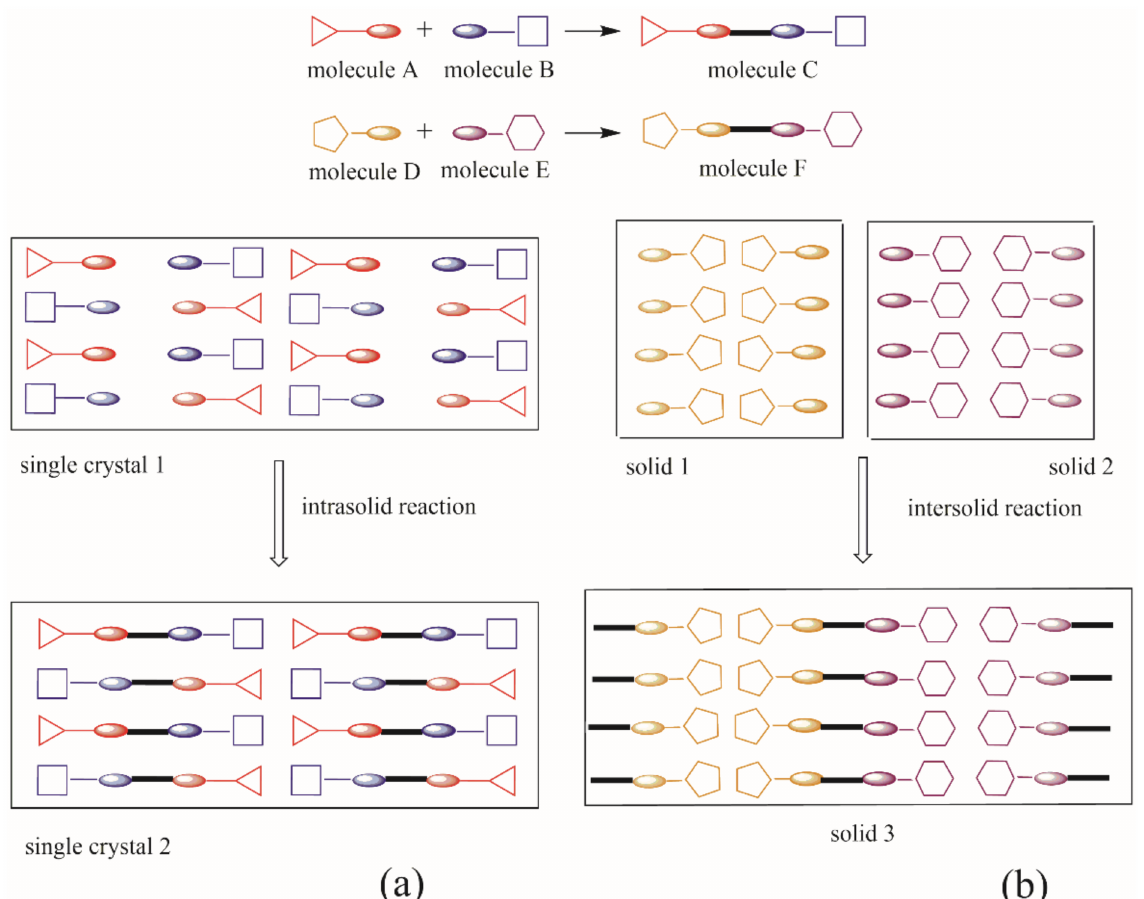
Figure 4. Classification of solid–solid reactions: ( a ) intrasolid and ( b ) intersolid. Adapted with permission from [189], Wiley,